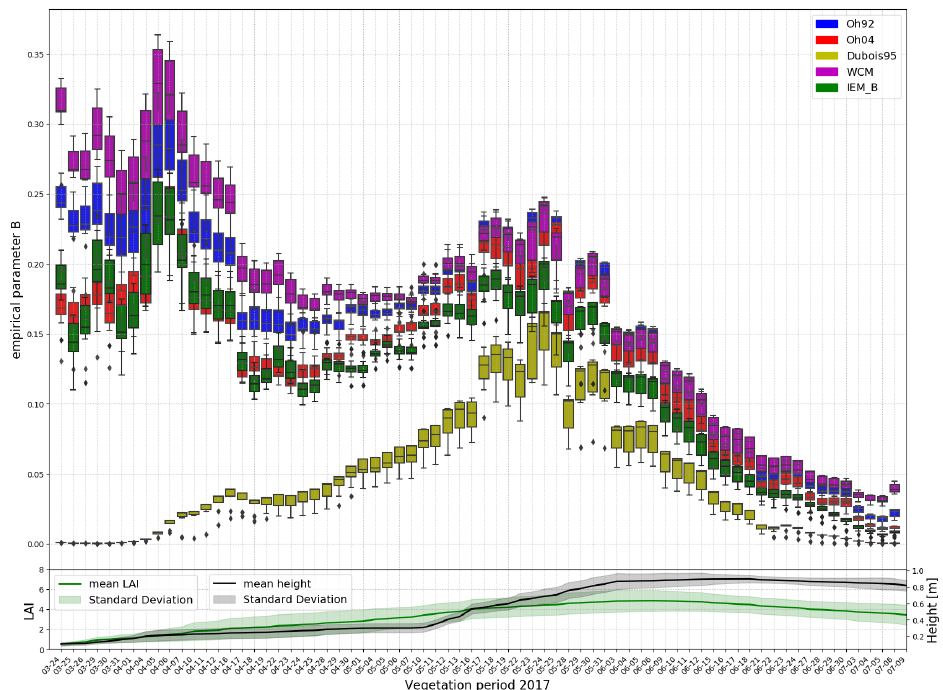
Figure 9. Evolution over time of non-static parameter B separated by different surface models (colors) for each Sentinel-1 acquisition date during vegetation period 2017. The box plots show the range of B used during the validation approach for different fields point ( top ). Mean and standard deviation of all measurement points for LAI and canopy height ( bottom ).